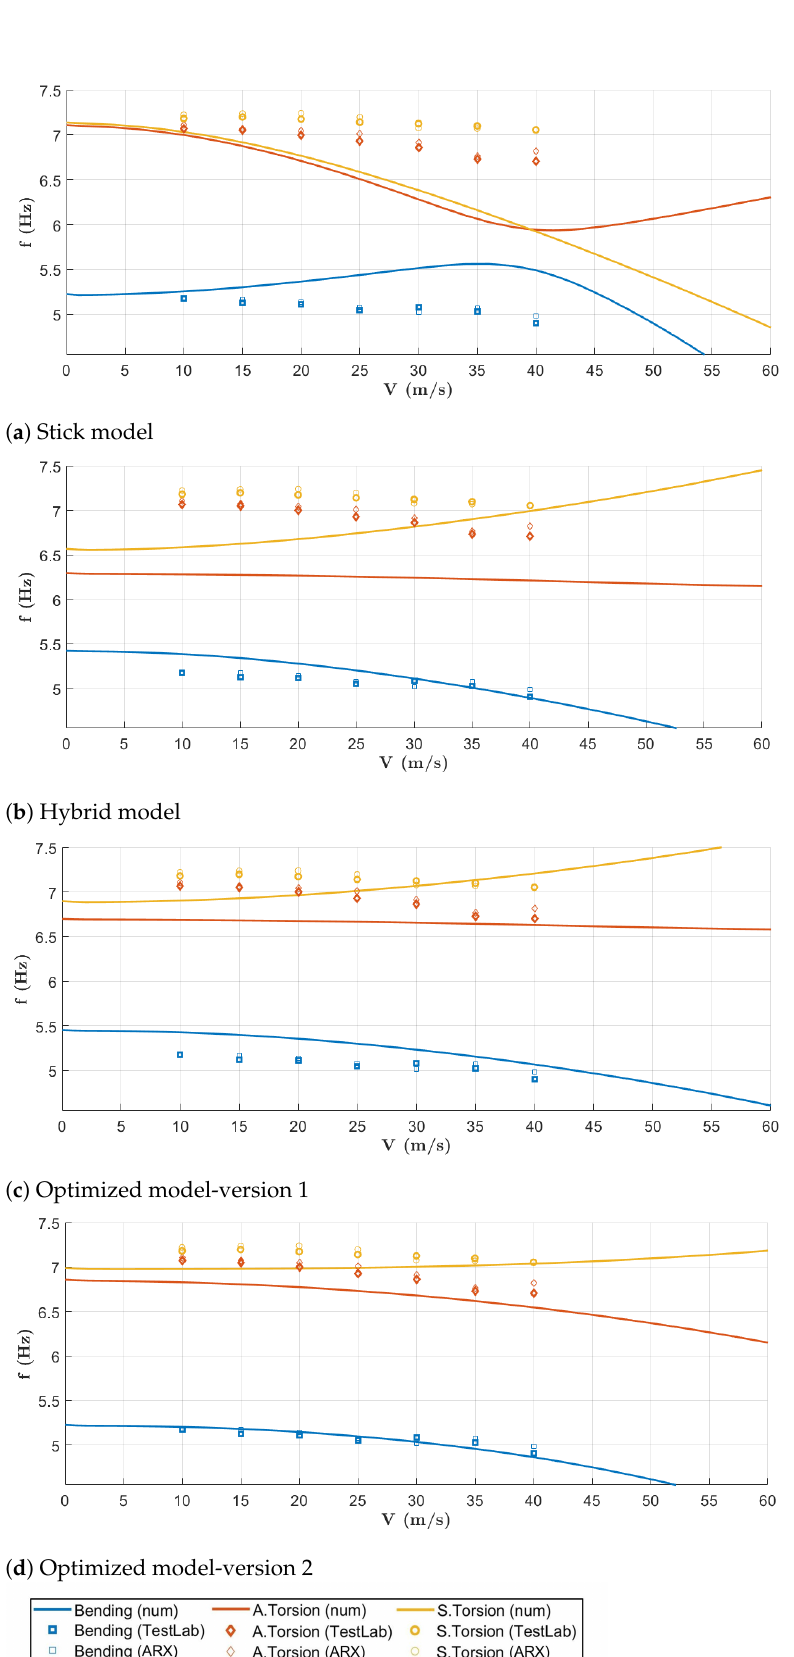
Figure 18. V − f plots of the mass-forward